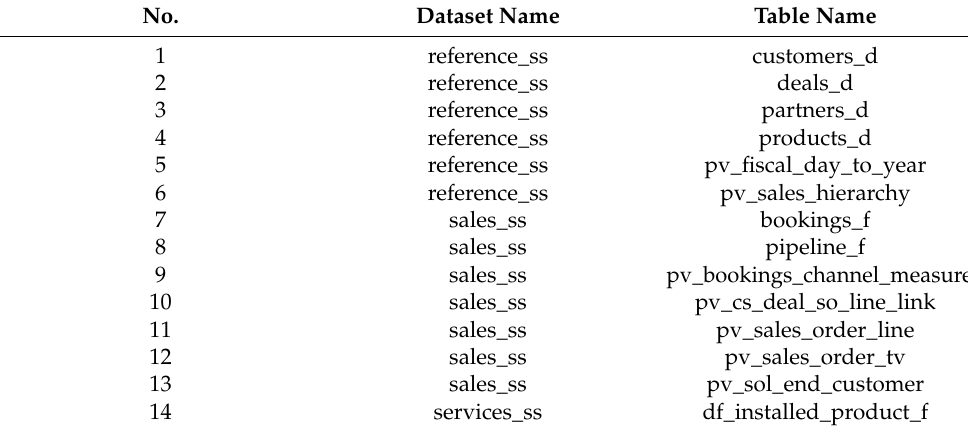
Table 1. Dataset Description.